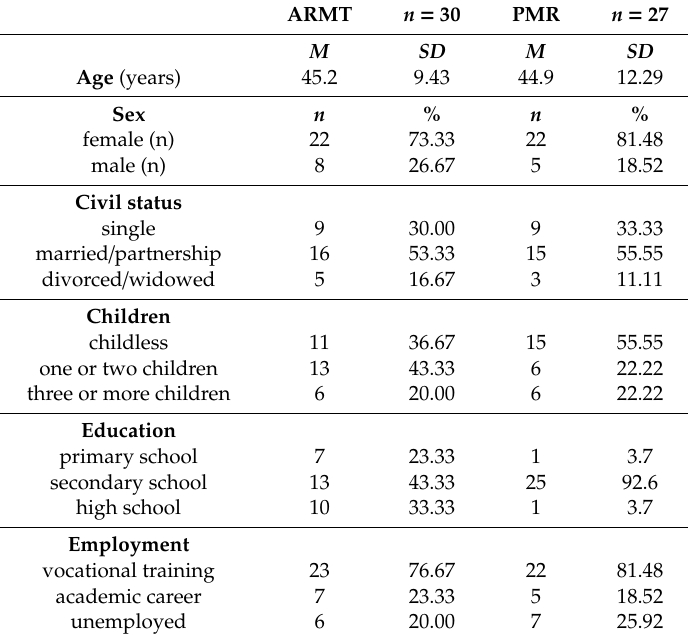
Table 1. Sociodemographic variables of the two patient